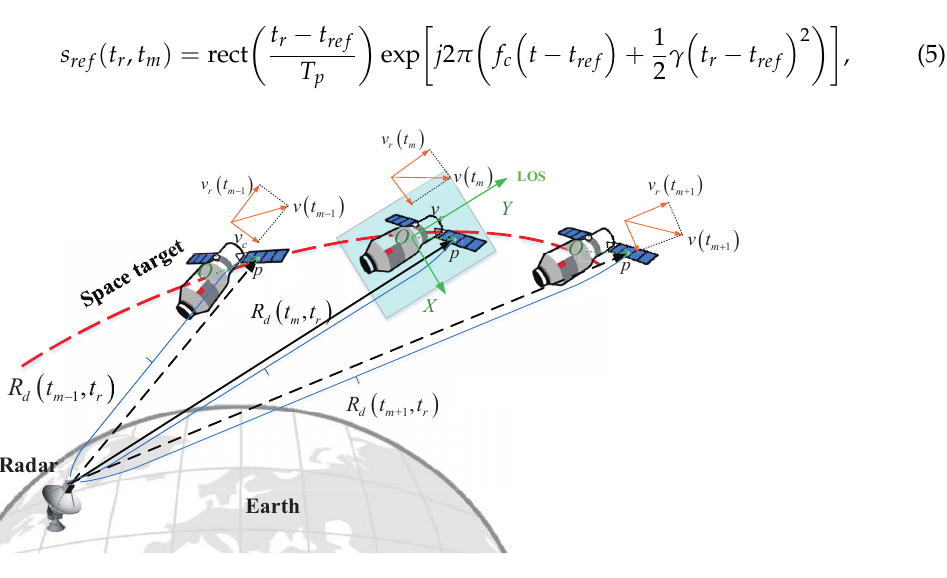
Figure 1. Observation geometry for high-speed motion targets.